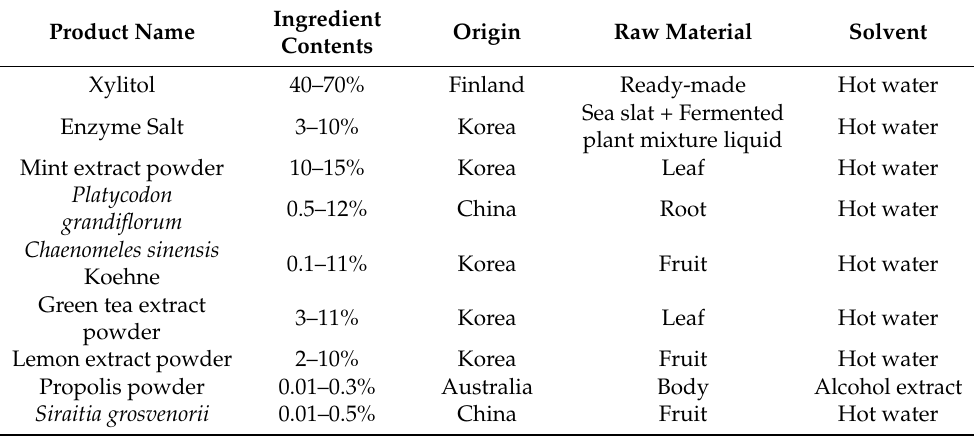
Table 3. Ingredients contained in the natural mixture series